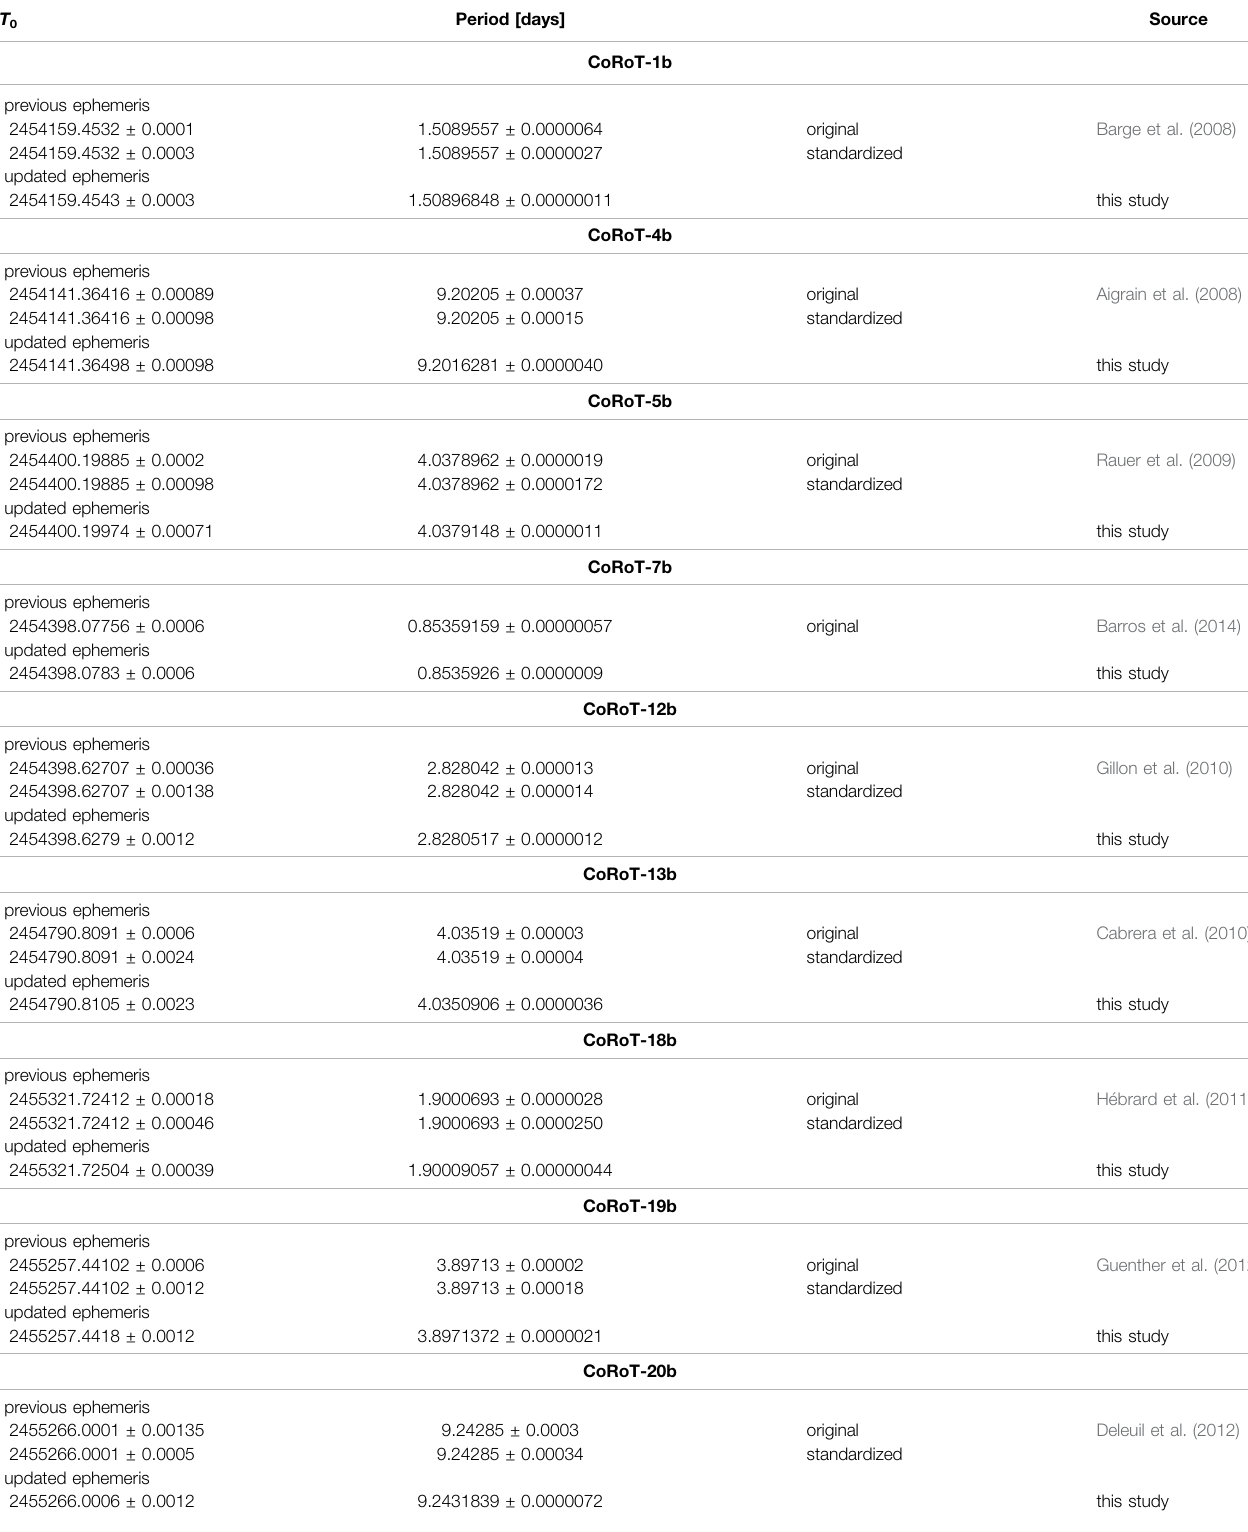
TABLE 2 | Previous and updated ephemerides of the analyzed planets. The updated ephemerides are in BJD TDB , while the previous ephemerides are in HJD UTC . The previous ephemerides are given with errors from the original literature and with standardized errors (see text Sect.